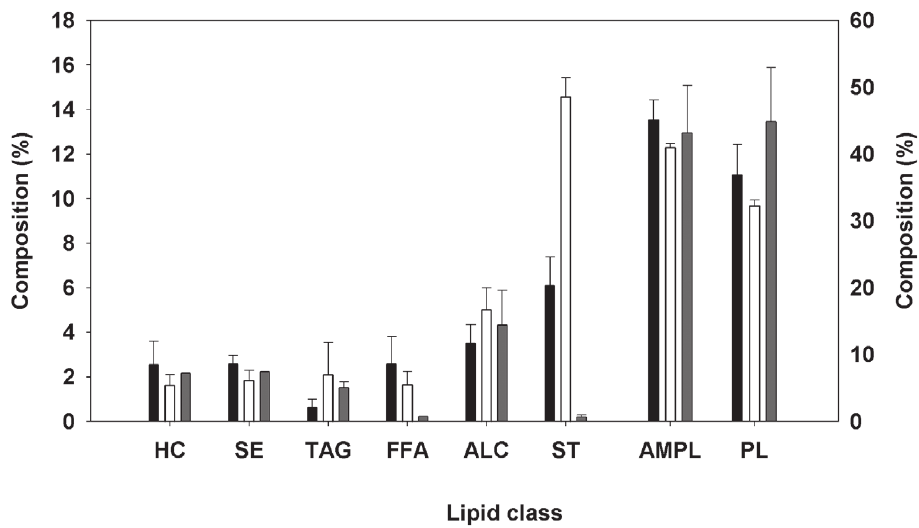
Figure 3 - Lipid class composition (%) of Chlorella vulgaris grown in different growth media (black bars: Chu; white bars: LC Oligo; gray bars: WC). Neutral lipids are represented by HC, SE/WE, TAG, FFA, ALC and ST, and polar lipids by AMPL and PL. Error bars represent standard deviation for n = 3. Chu = Chu medium, WC = WC medium, LC Oligo = LC Oligo medium. Right axis applies to AMPL and PL